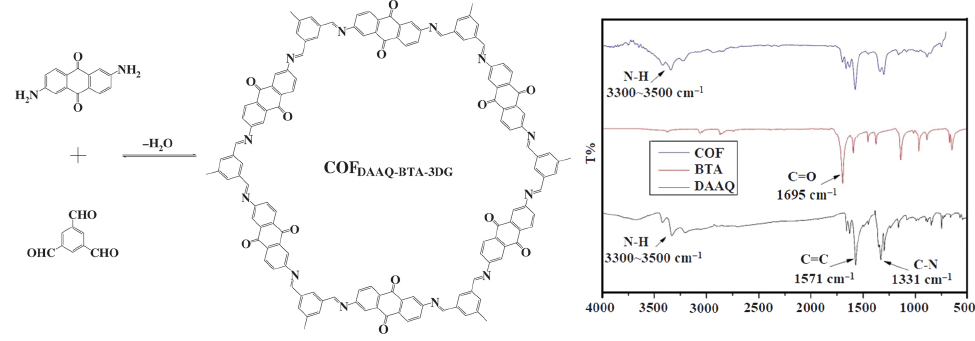
Figure 3: The synthesis and FT-IR spectra of COF